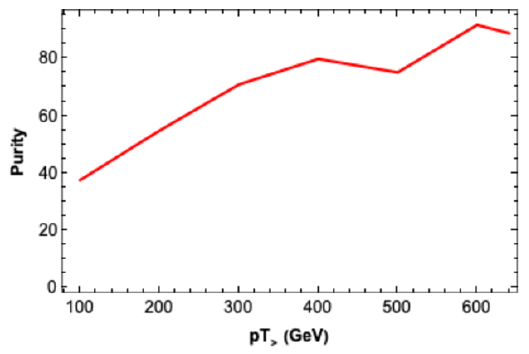
Figure 6 . Purity N j(cid:13) = ( N j(cid:13) + N jj ) of the ja samples with a single photon and a